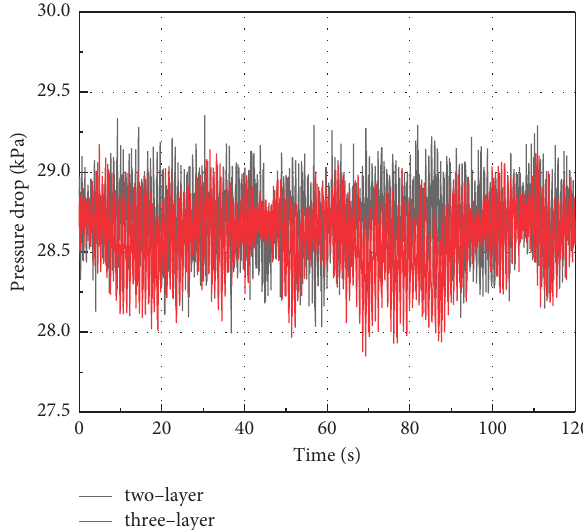
Figure 13: Pressure drop between the inlet and outlet of flow passage at q � 1600kW/m 2